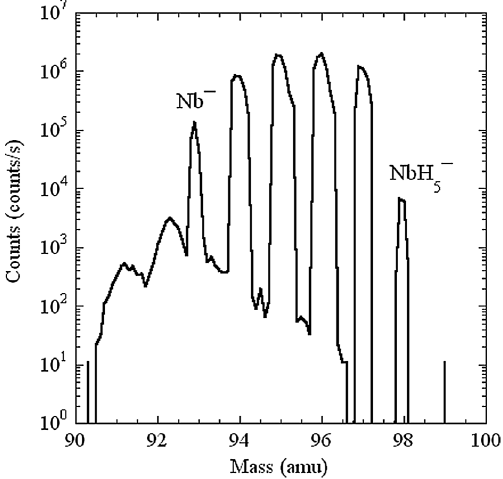
FIG. 23. SIMS mass spectrum of control sample L14.